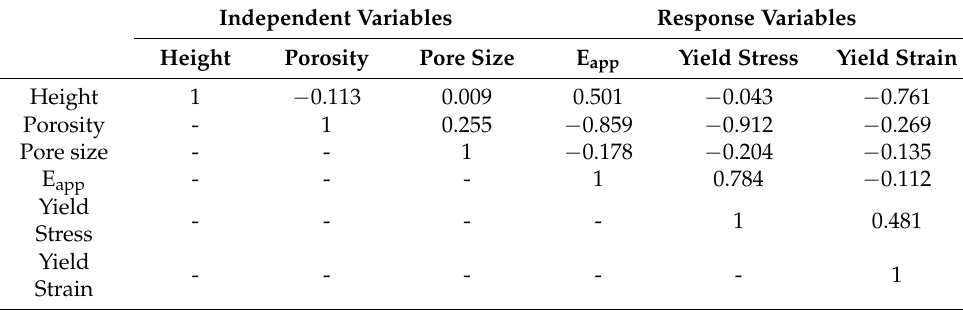
Figure 5. Standardized modulus (measured elastic Modulus E p divided by the material modulus E 0 ) versus the porosity for three specimen heights. Data from the current study is overlayed with published curves [45–52]. Table 4. Spearman correlation coefficients between the study variables.